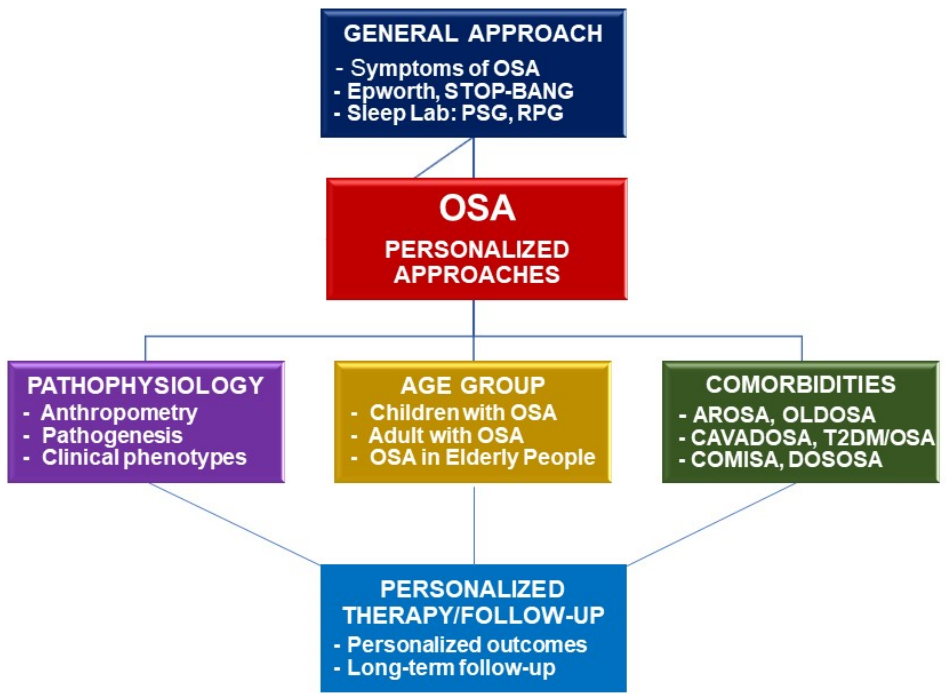
Figure 4. Framework of personalized approaches for diagnosis and treatment of OSA. OSA: obstructive sleep apnea; PSG: polysomnography; RPG: respiratory polygraphy; AROSA: allergic rhinitis and OSA; OLDOSA: obstructive lung disease and OSA; CAVADOSA: cardiovascular diseases and OSA; T2DM: type 2 diabetes mellitus; COMISA: comorbid insomnia and OSA; DOSOSA: Down syndrome and OSA.